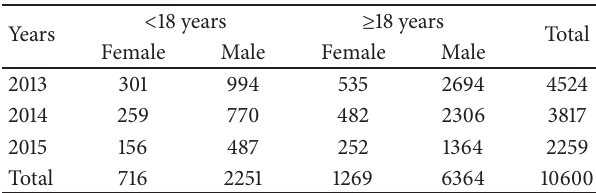
Table 4: Distribution of persons killed and injured by age and sex ( 𝑁 = 10600 ).